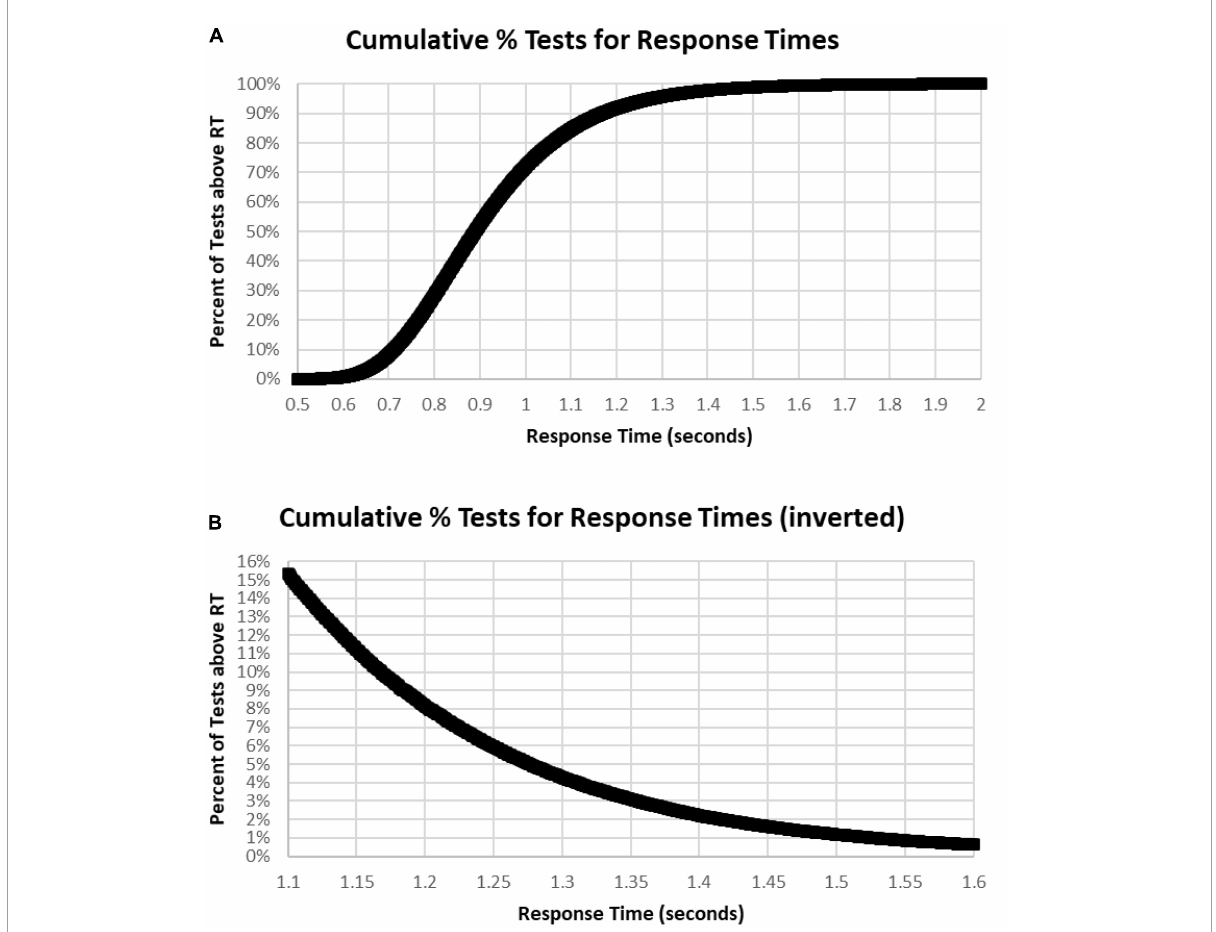
FIGURE7 (A) Cumulative percentage of tests with respect to RT. Note that level is below 1% until over 0.620 s and 99% had RTs less than 1.570 s. Median RT was 0.900 s, at 50%. (B) Inverse of (A) at higher resolution to show the slower 15%, more than 1.1 s, and the slower 1%, more than 1.6